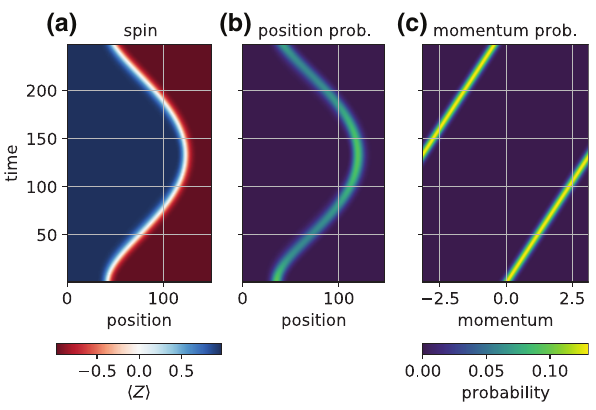
FIG. 5. Evolution of a single kink in the Z 2 -broken Ising model (parameters λ = 0, g = 0.4, h = 0.01). The vacuum bond dimension D = 6 is allowed to evolve to a maximum D ≤ 32. The meson mass is m μ ≈ 2.36 and v max ≈ 0.83, both in unscaled units of Eq. (1). Spin expectation values (cid:2) Z (cid:3) are shown (a), as is the position-basis probability (b) |(cid:2) κ j | ψ( t ) (cid:3)| 2 . The momentum (c) is obtained from the Fourier transform of the position-basis projection.